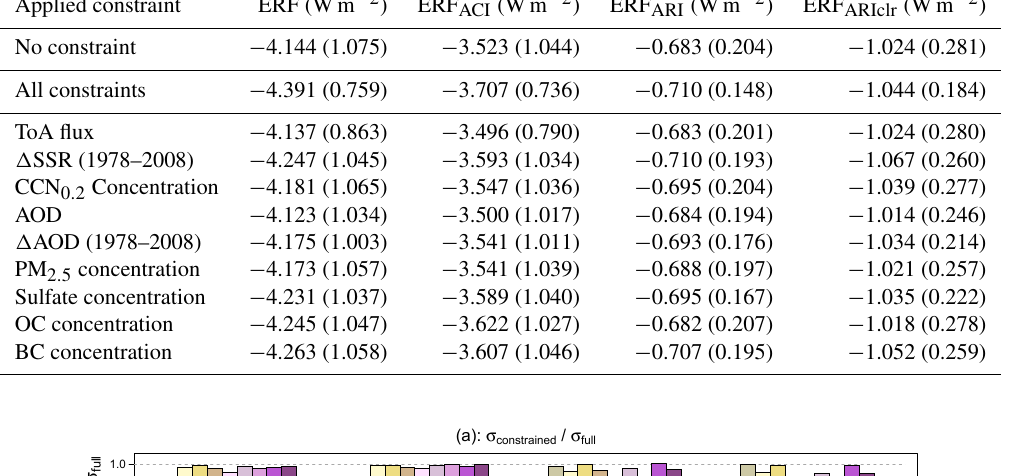
Table 6. Mean and standard deviation (in brackets) of the forcing distributions over Europe in July for the original unconstrained sample, the multiple-constraint sample and the individually constrained samples where each observational constraint is applied independently. Applied constraint